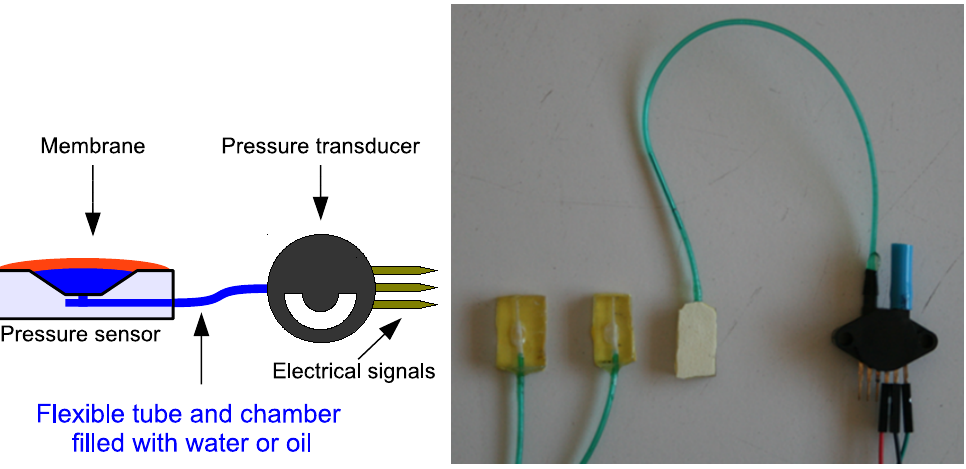
Figure 3. Possible miniaturizable setup for the usage of a pressure transducer to measure fingertip pressure while